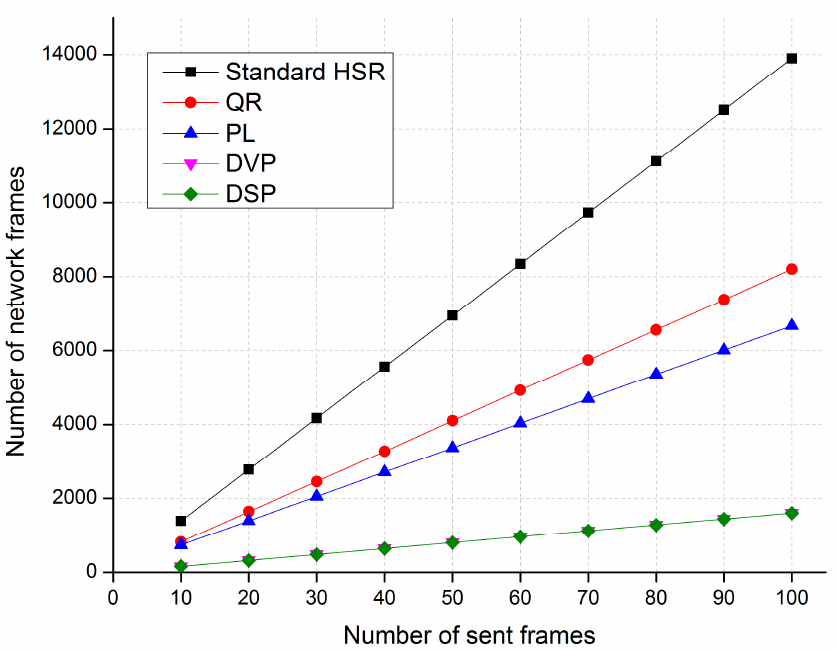
Figure 11. A comparison of traffic performance in Case 1.